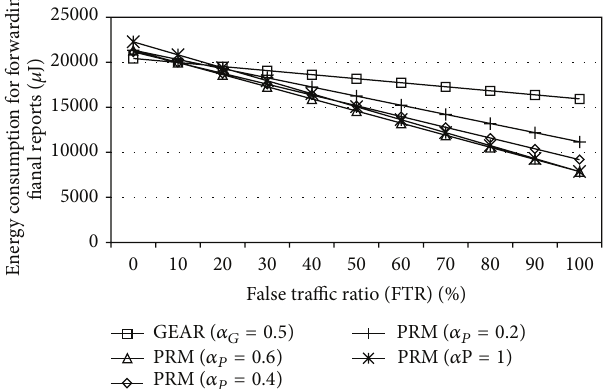
Figure 11: Energy consumption for forwarding final reports.